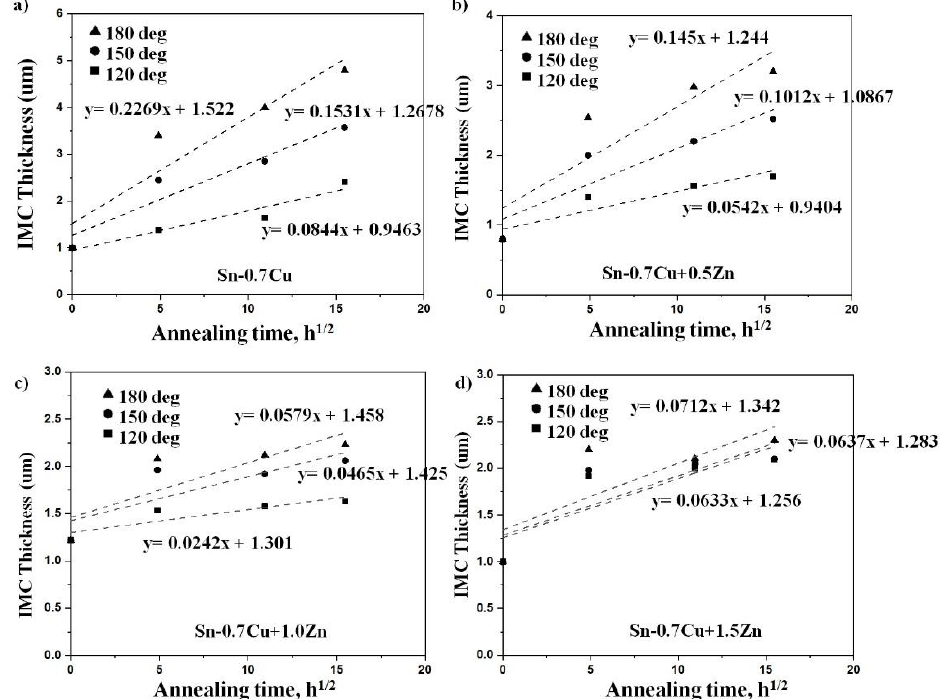
Figure 12. Relationship between interfacial IMC layer thickness with annealing time for ( a ) Sn-0.7Cu, ( b ) Sn-0.7Cu-0.5Zn, ( c ) Sn-0.7Cu-1.0Zn, and ( d ) Sn-0.7Cu-1.5Zn.